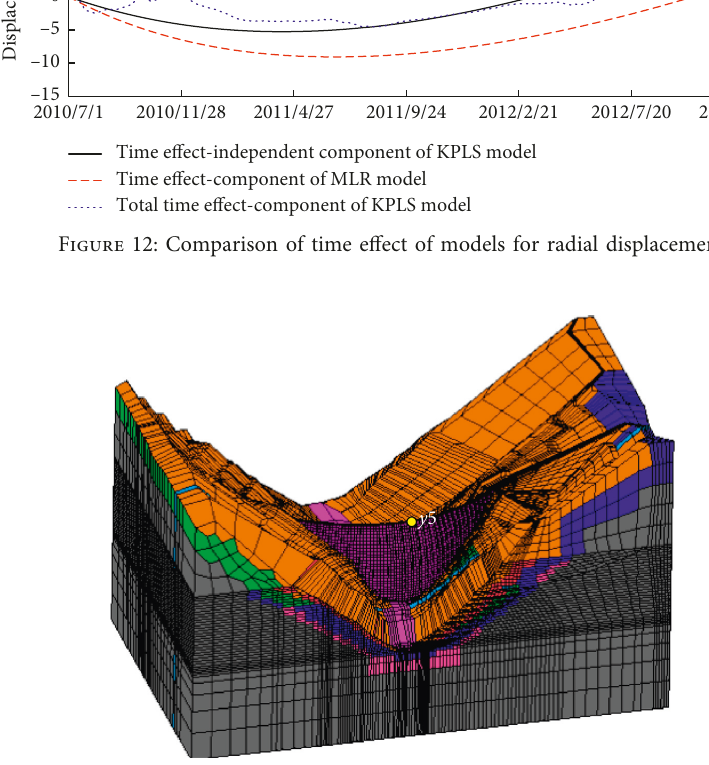
Figure 13: 3D finite element model of the